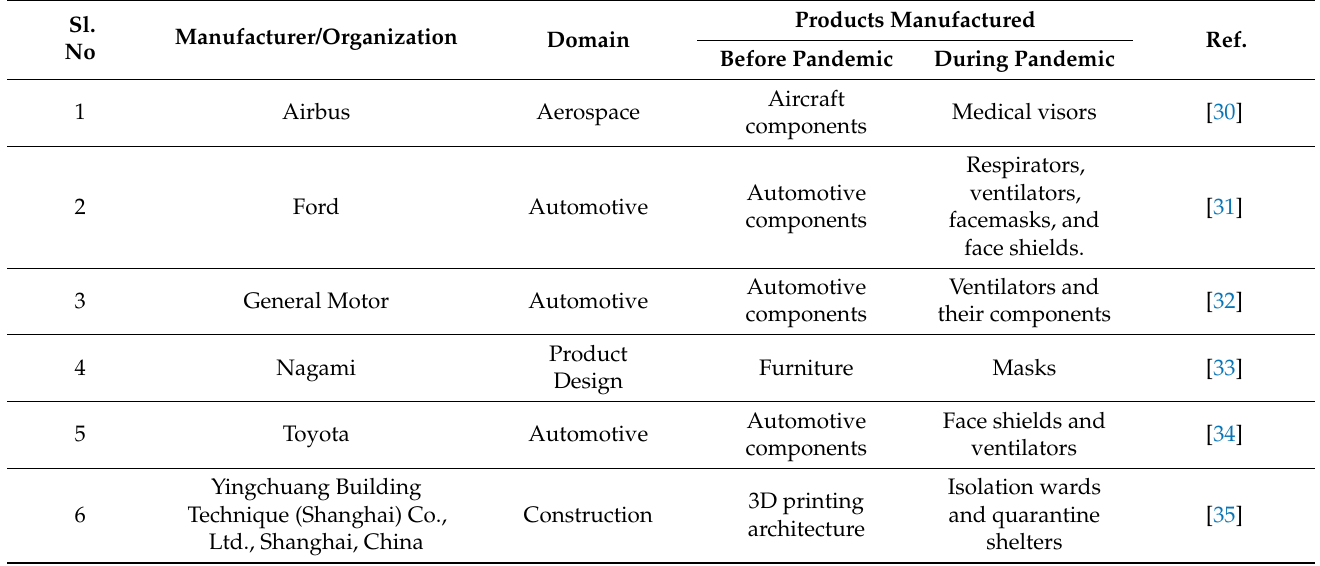
Table 1. Products produced by prominent manufacturing industries/organizations with 3D printing facilities before and during the